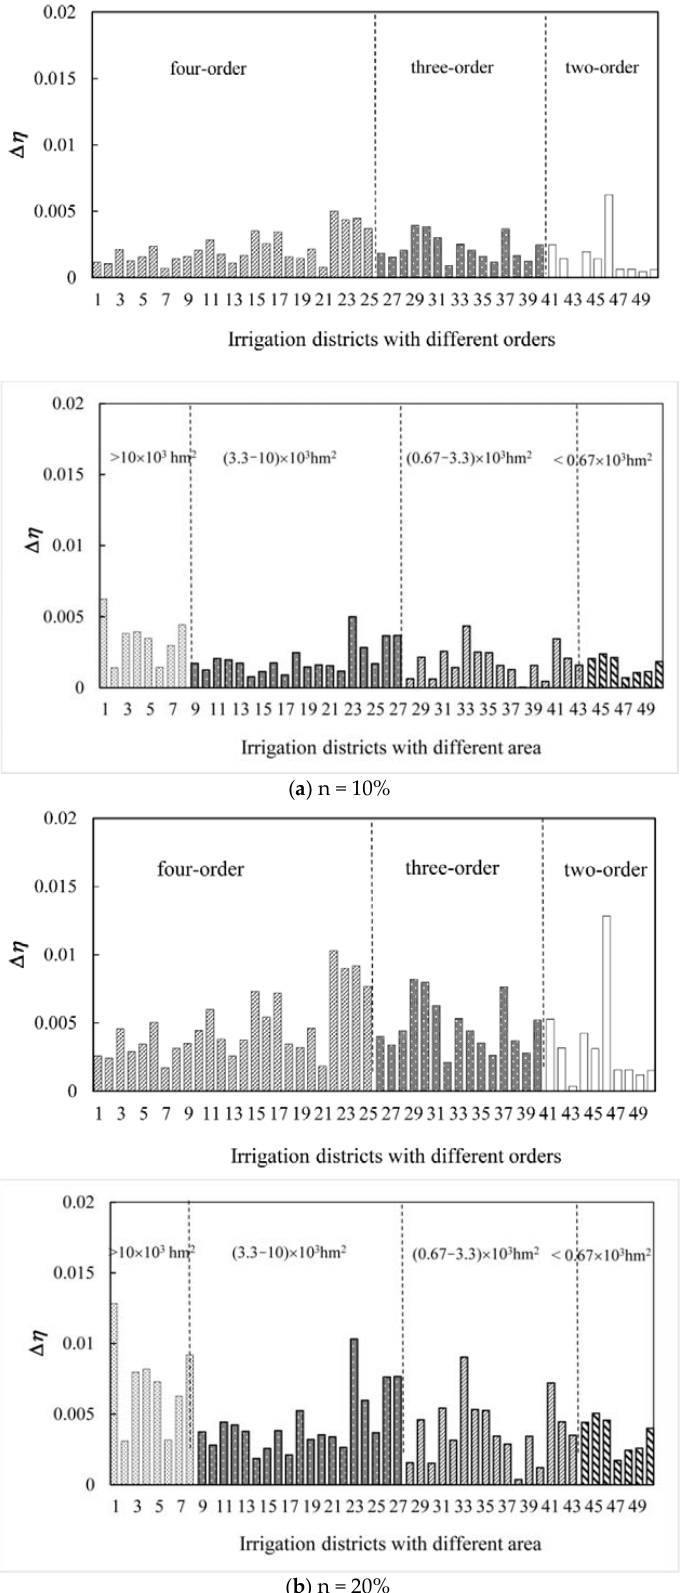
Figure 6. Change in irrigation water use efficiency with increases in D.